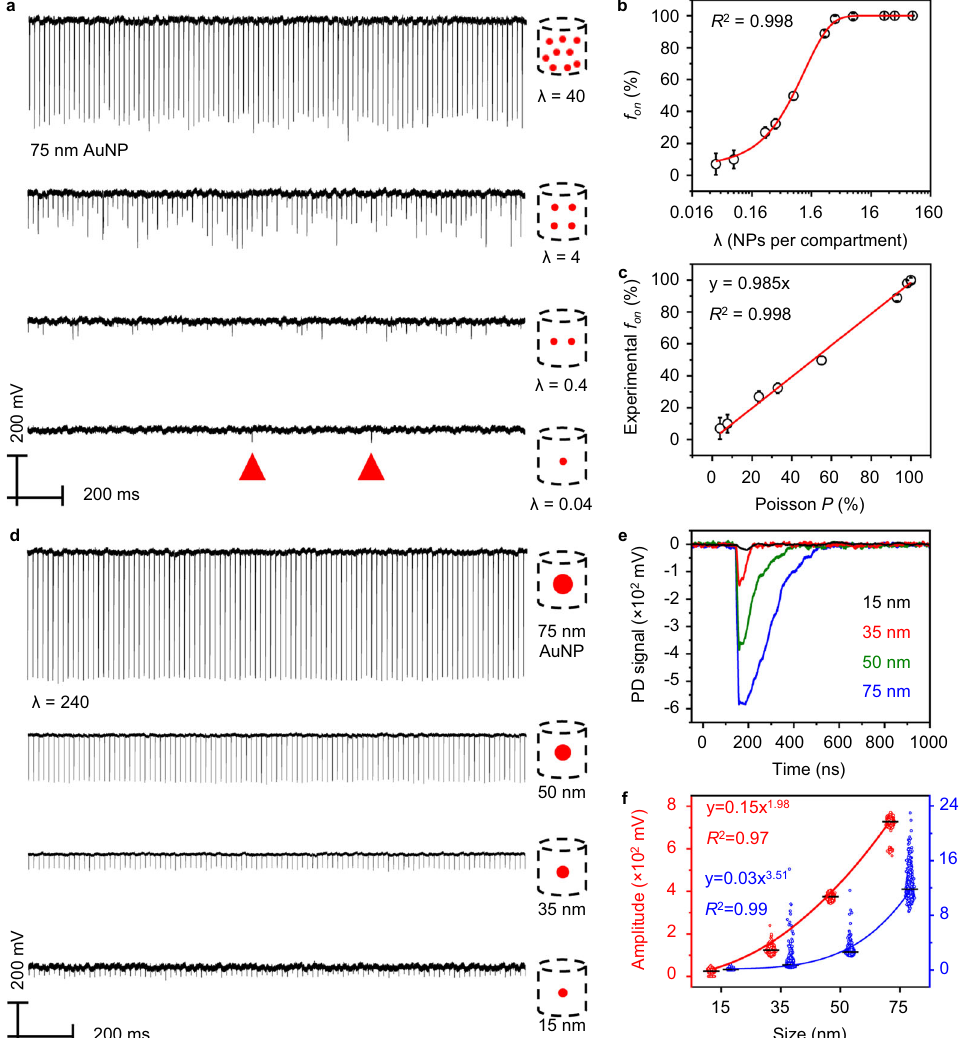
Fig. 2 Detection of AuNPs and size differentiation by DIAMOND. a Representative PNB signal traces (100 pulses) for 75 nm AuNP suspensions with different particle concentrations. Schematics represent the decreased number ( λ ) of AuNPs per detection. Red triangles mark the positive PNB signals. b Quanti fi cation of AuNP concentrations by plotting the frequency count ( f on ) against λ . A one-phase exponential association fi tting is applied for the calibration curve. c Linear correlation between experimental f on and the theoretical probability ( P ) based on Poisson statistics. d Representative PNB signals traces (100 pulses) for AuNP suspensions with different sizes. Schematics represent the increasing AuNP sizes and same AuNP number per detection. e Individual PNB signals extracted from ( d ). PD is photodetector. f Correlations between the amplitude and area-under-curve (AUC) of PNB signals as a function of AuNP size. Black lines denote the statistical average values. Error bars in ( b ) and ( c ) indicate the standard deviations of three independent shows representative PNB signal traces and corresponding bivariate plot taken from serial assay solutions, respectively. Similarly, the thresholds ( T = μ + 5 σ ) of amplitude and AUC were calculated from the control group (highlighted in dashed lines) and assigned for counting “ on ” signals. The f on was then plotted as a function of λ or particle concentration of SiO 2 beads (Fig. 4e). A linear relationship ( R 2 = 0.99) in the range of 0.0016 – 0.16 was observed and the limit of detection (LOD) was calculated to be 0.0028, equivalent to 1.75 × 10 5 mL − 1 or 290 aM (inset of Fig. 4e). Such detection limit is ~570-fold lower than the colorimetric detection (Fig. S6). It should be pointed out that the detection range of DIAMOND only covers 2 logs due to the limited counting number (i.e., 3000 pulses). Alternatively, we can use an analog method to analyze PNB signals (e.g., averaged AUC versus analyte concentration), which should provide an addi- tional detection range beyond 100% f on 12,30 . Furthermore,